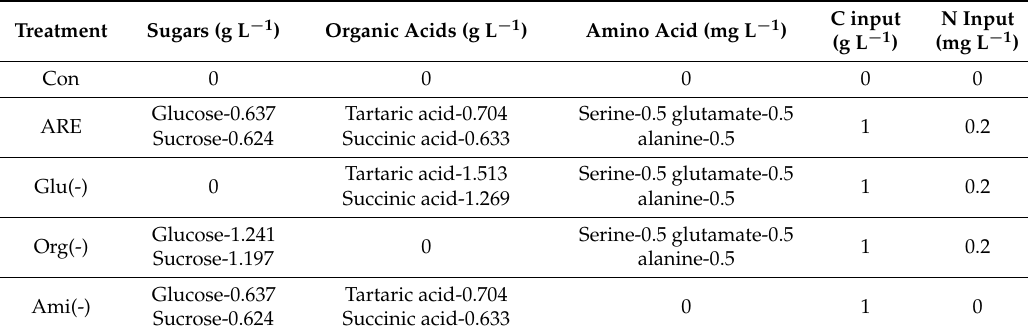
Table 1. Composition of supply LMWC solution